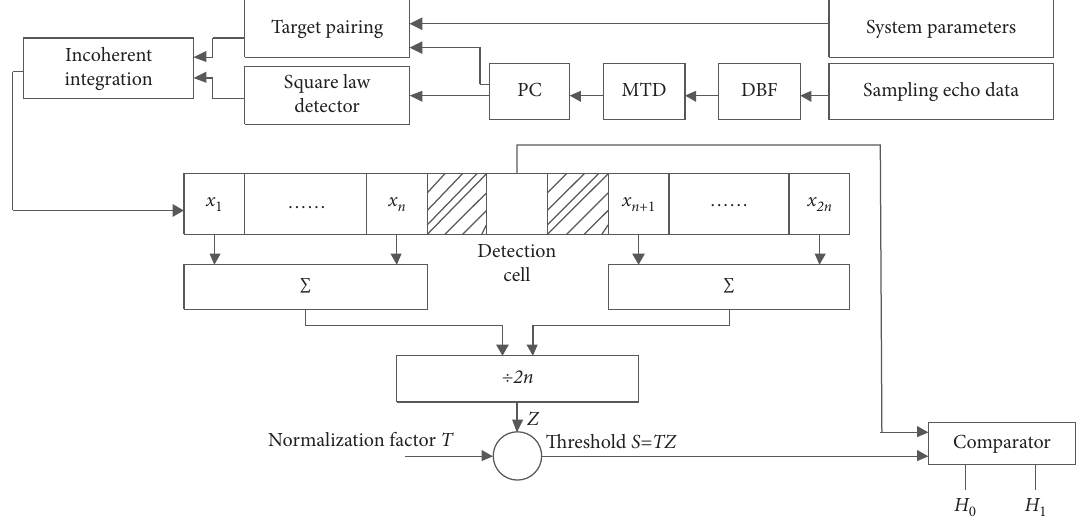
Figure 3: The proposed incoherent integration detection